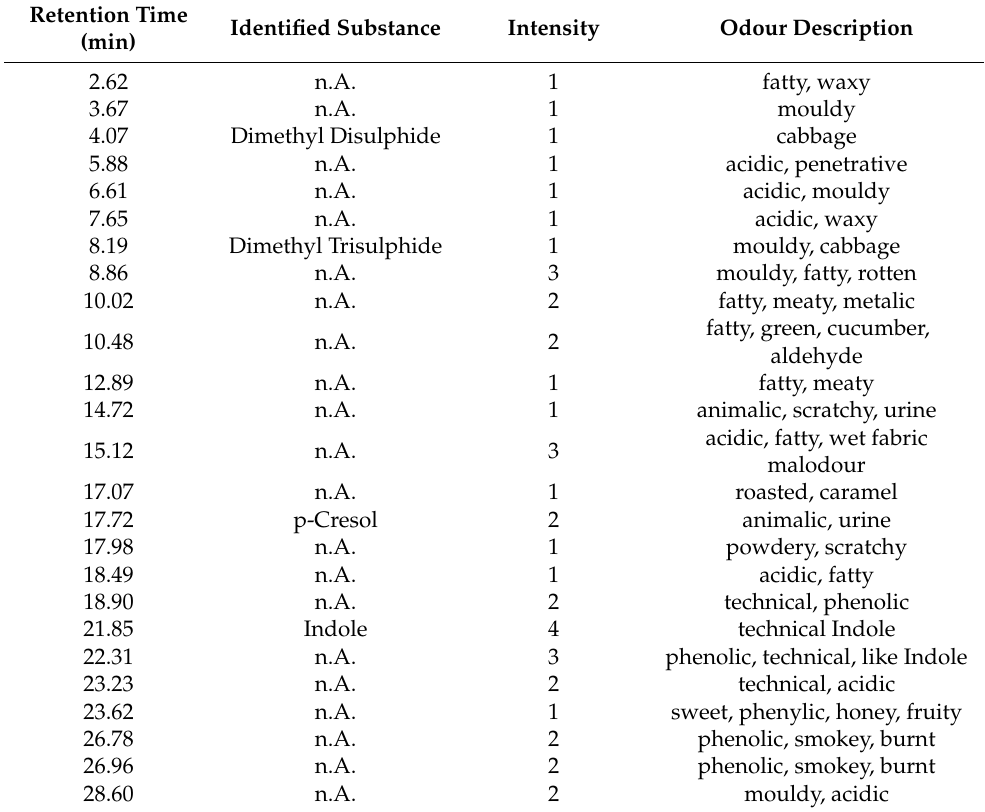
Table 5. GC/O results for the MlShCj sample. Intensity range: 1 = weak to 4 = very strong; n.A. = not